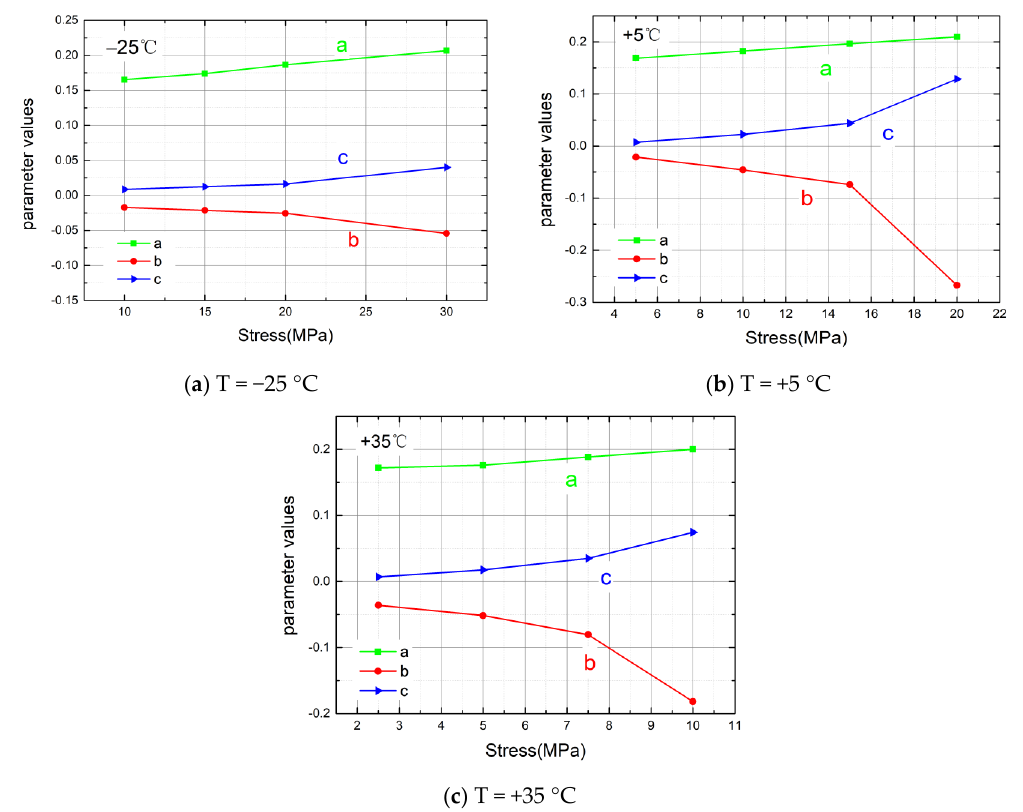
Figure 10. ( a ) Variation trend of model parameters with stress at T = − 25 °C. ( b ) Variation trend of model parameters with stress at T = +5 °C. ( c ) Variation trend of model parameters with stress at T = +35 °C.